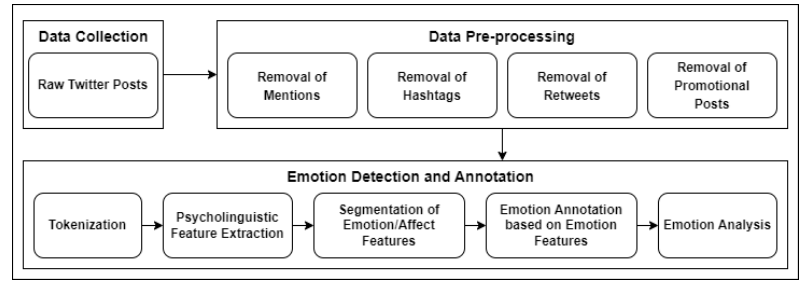
Figure 5. Overview of proposed mechanism for emotion detection and